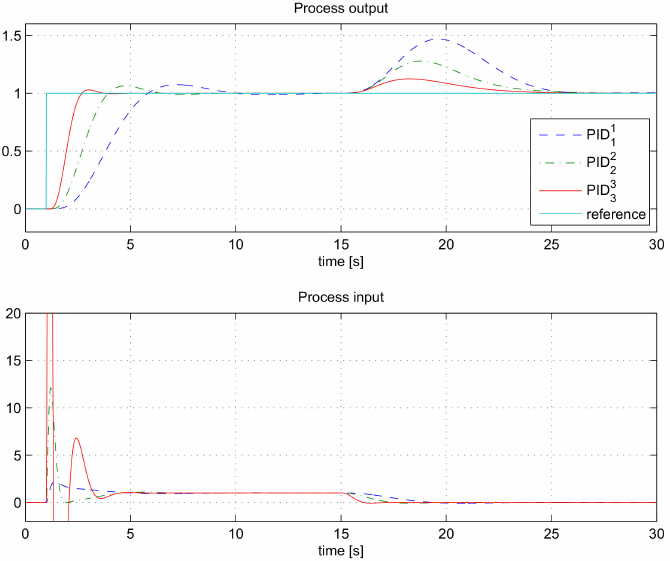
Figure 3. The closed-loop responses for the process G P 1 (s) when using controllers PID 1 and PID 3 . 3